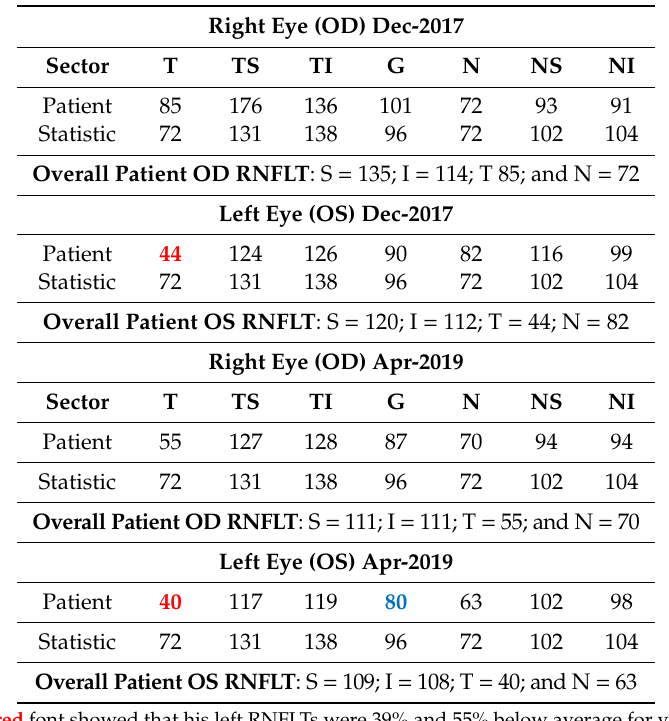
Table 1. Patient’s retinal nerve fiber layer thickness (RNFLT µ m) data for December 2017 and April 2019 compared with statistical information from age- and sex-matched individuals in the